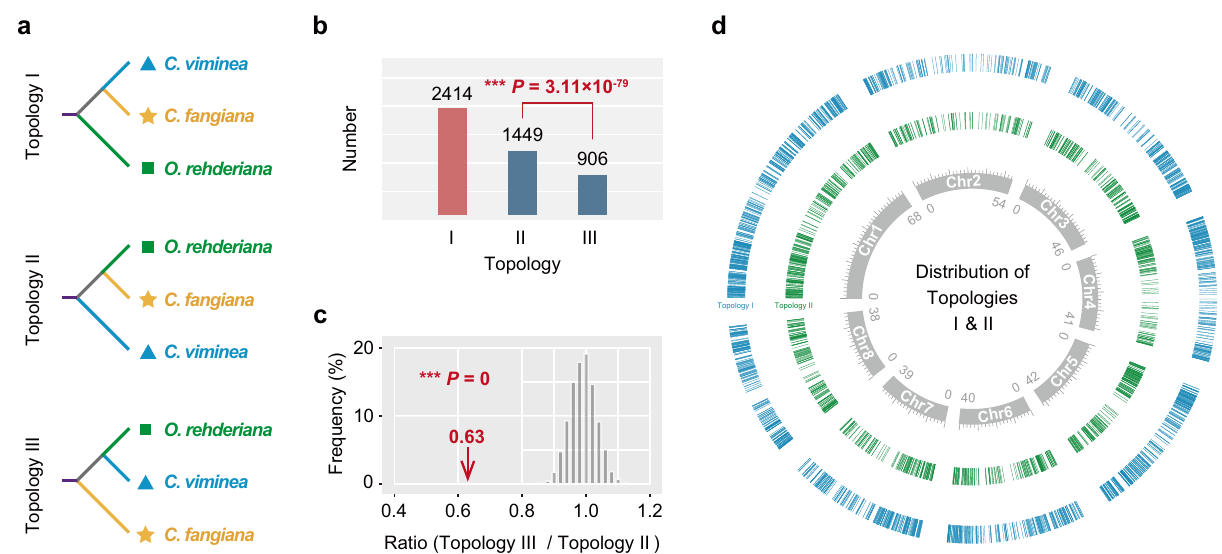
Fig. 3 High incongruence in gene-tree phylogenies. a , b Phylogenetic topologies ( a ) and the corresponding numbers (shown on the top of bar charts in ( b ) revealed from the phylogenies of 4769 strictly orthologous nuclear gene pairs with high-con fi dence support values ( ≥ 50). The number for Topology II was signi fi cantly more ( P = 3.11 × 10 − 79 ) than that for Topology III. c Simulations under solely ILS scenario. The red arrow indicates the observed ratio (Topology III/Topology II) from 4769 ortholog groups (see in b ). The gray bars are a histogram of the ratios obtained in 10,000 simulated datasets. The solely ILS hypothesis was strongly rejected due to a signi fi cant difference ( P = 0) between observed and simulated ratios. d Genome-wide distribution of Topologies I (blue bars) and II (green bars). Statistical signi fi cance was determined by a two-tailed one-sample binomial test ( b ) and a two-tailed one- sample Student ’ s t test ( c ). Signi fi cant differences are indicated with asterisks ( *** P < 0.001). Source data are provided as a Source Data fi